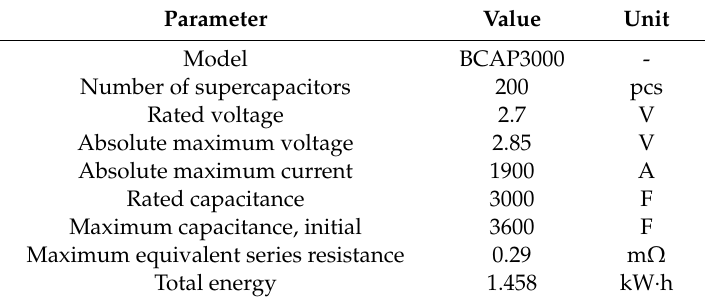
Table 2. Supercapacitor parameters.